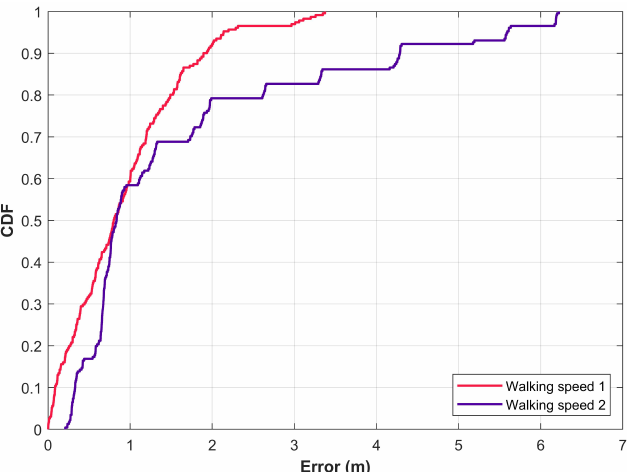
Figure 11. Performance of magnetic field-based indoor positioning approach involving various walking